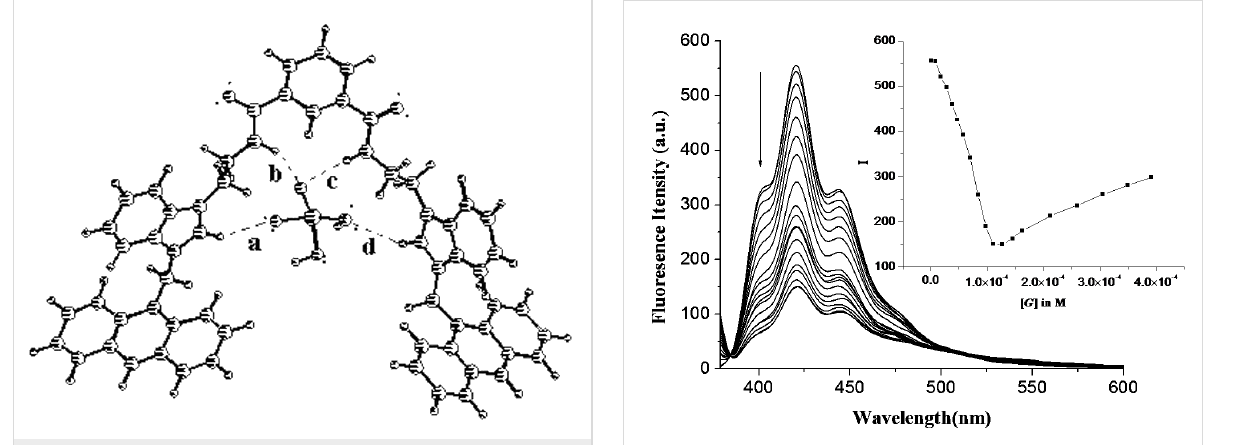
Figure 4: Change in emission spectra of 1 ( c = 5.78 × 10 − 5 M) in pres- ence of increasing amounts of H 2 PO 4 − in CH 3 CN; Inset: Plot of fluo- rescence intensity vs concentration of H 2 PO 4 −